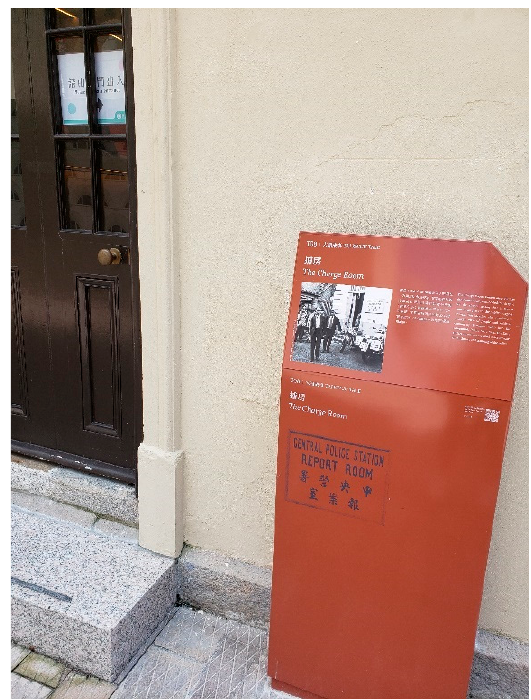
Figure 2. Tai Kwun sightseeing tour and exhibition.